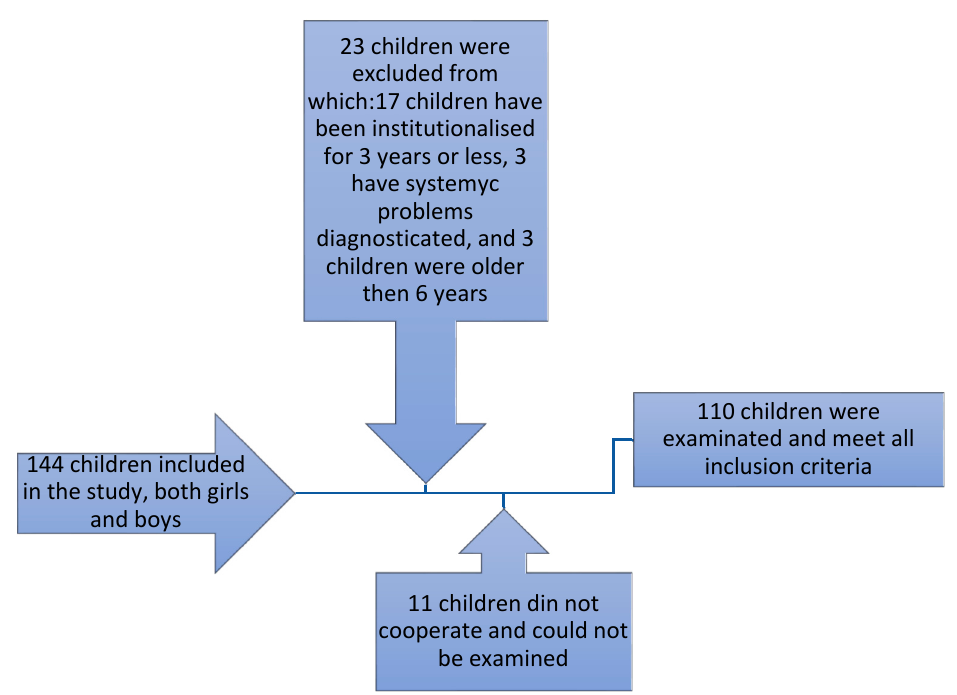
Figure 1. Diagram illustrating the selection of the young patients included in the study.